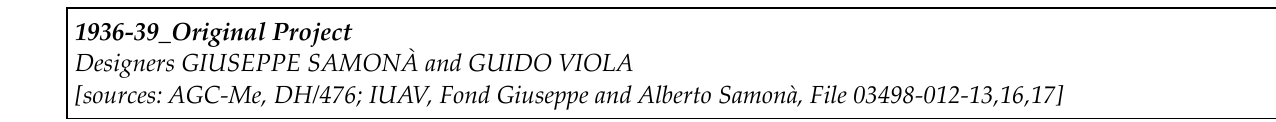
Figure 7. The method to historicise a BIM model.